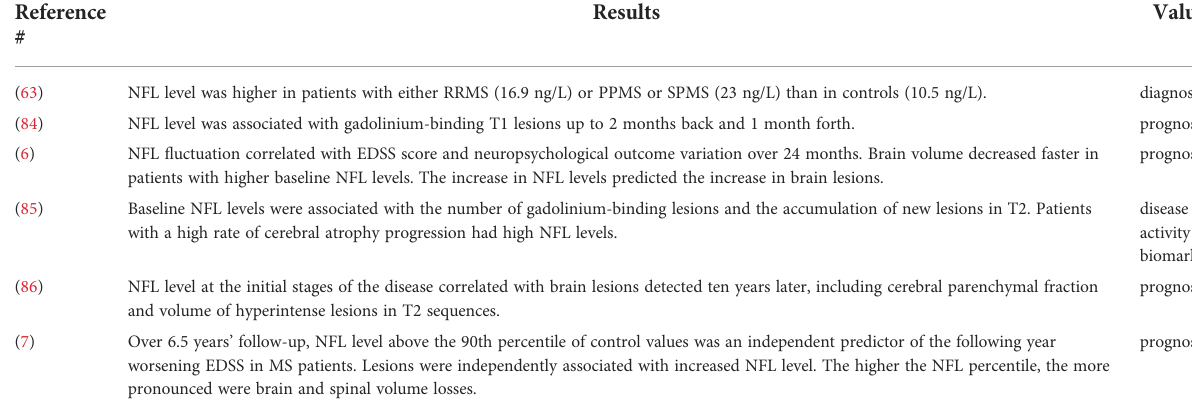
TABLE 1 Findings supporting the biomarker value of circulating NFL concentration in